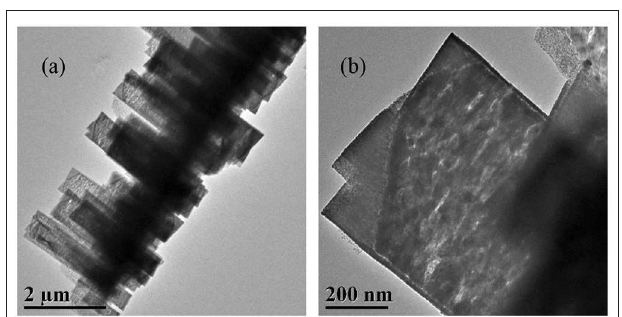
FIGURE 3 | TEM images of Ni 0.4 Cu 0.6 O catalyst with low (a) and high (b)